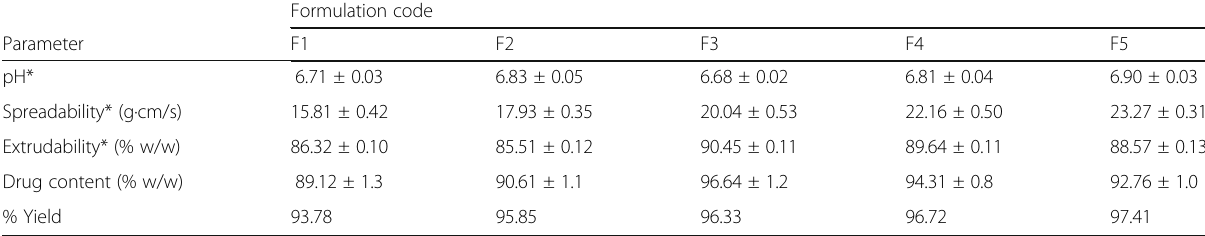
Table 2 Evaluation parameters of camptothecin gel formulation Formulation code